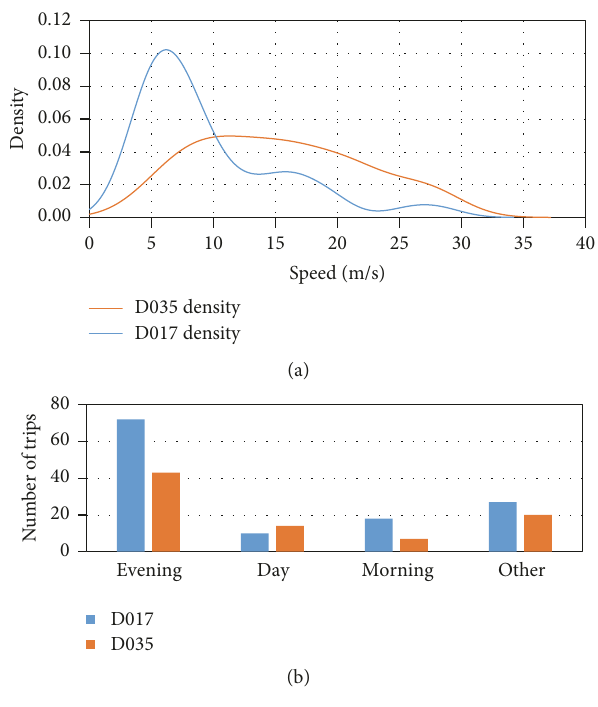
Figure 1: Distribution of important parameters of journey for 2 drivers . (a) Distribution of average speed. (b) Trips occurring at various time of